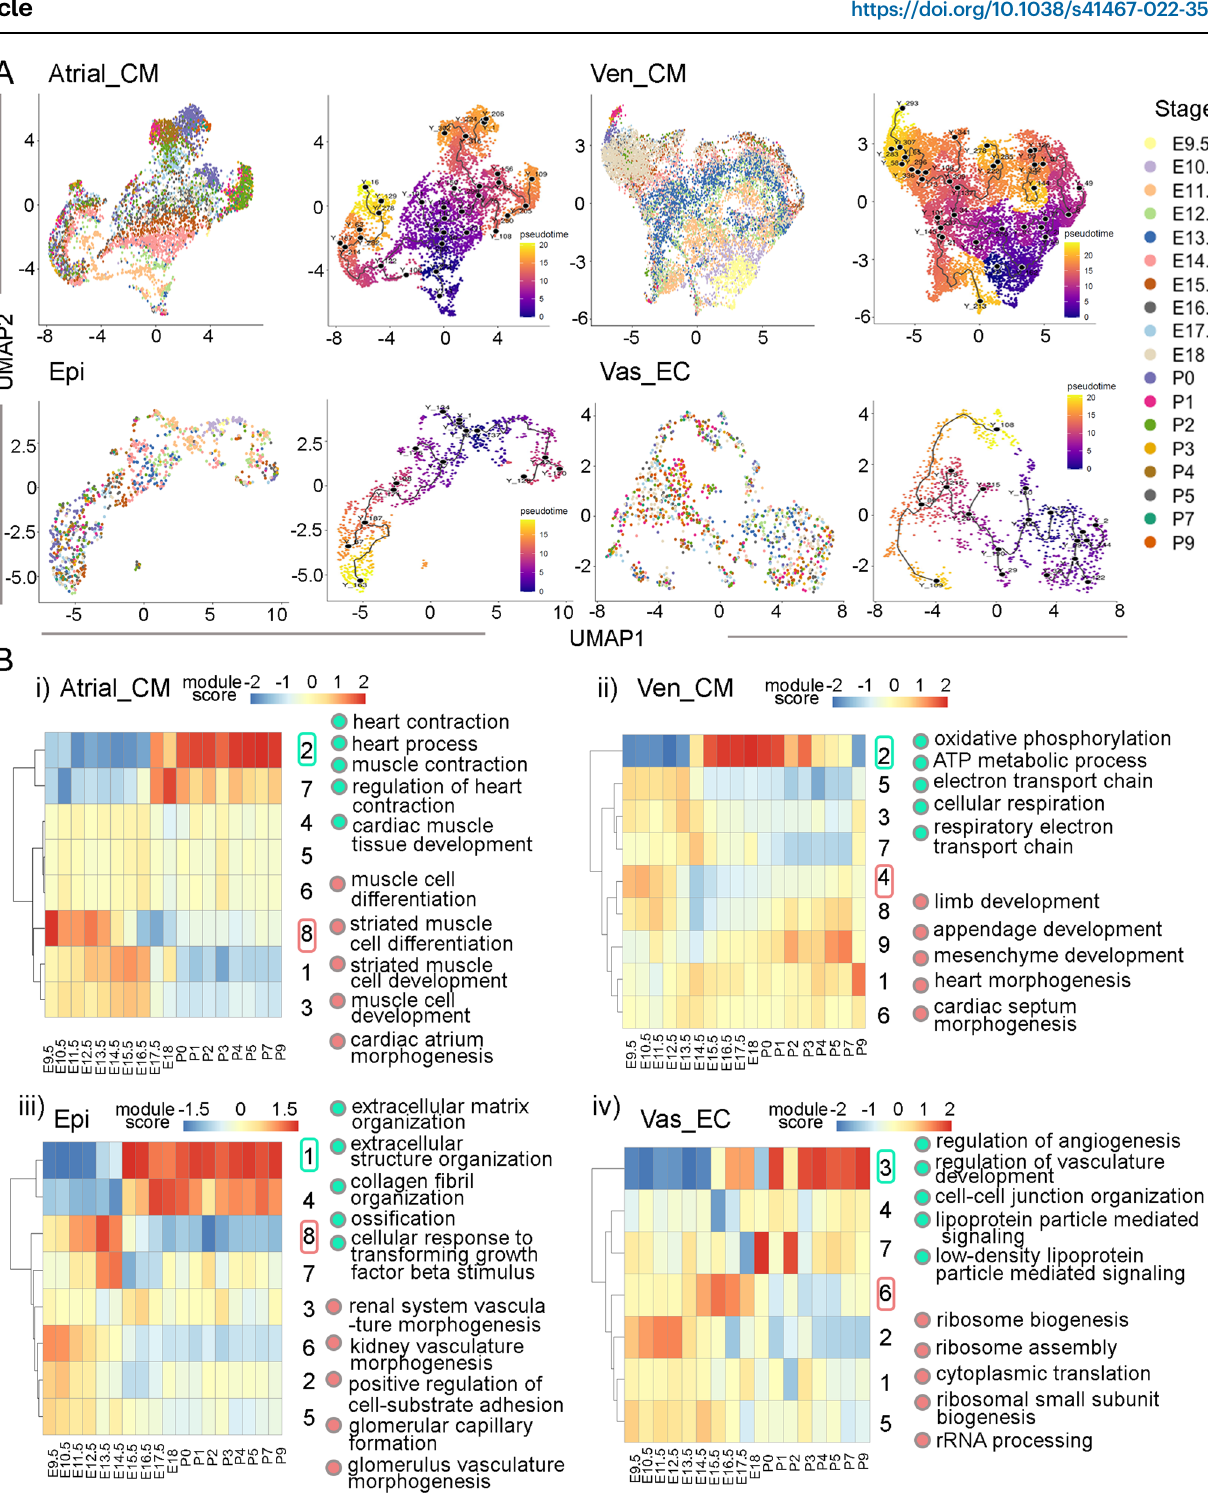
Fig.2|Stagedpatternofgeneexpressionmodulesineachcelltype.A UMAPof singlecelllineageslabeledwithstagesandpseudo-timeinformation. B Stagedgene